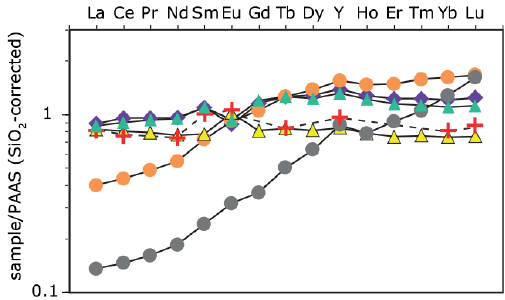
Figure 5. REE( + Y) distribution pattern of averages of samples from the Pfitsch area; abbreviations are as follows: LQ is lazulite quartzite; ZG is Zentralgneis (data from Finger et al., 1993); MS is mica schist; TG is tourmaline gneiss; PQ is pyrite quartzite; MCSC is magnetite–chloritoid–staurolite–chlorite lens. Normalization to post-Archean Australian shale (PAAS) composition (normalization values from Pourmand et al., 2012). Due to the very high quartz content of several samples, all values were corrected for SiO 2 con- tent (see